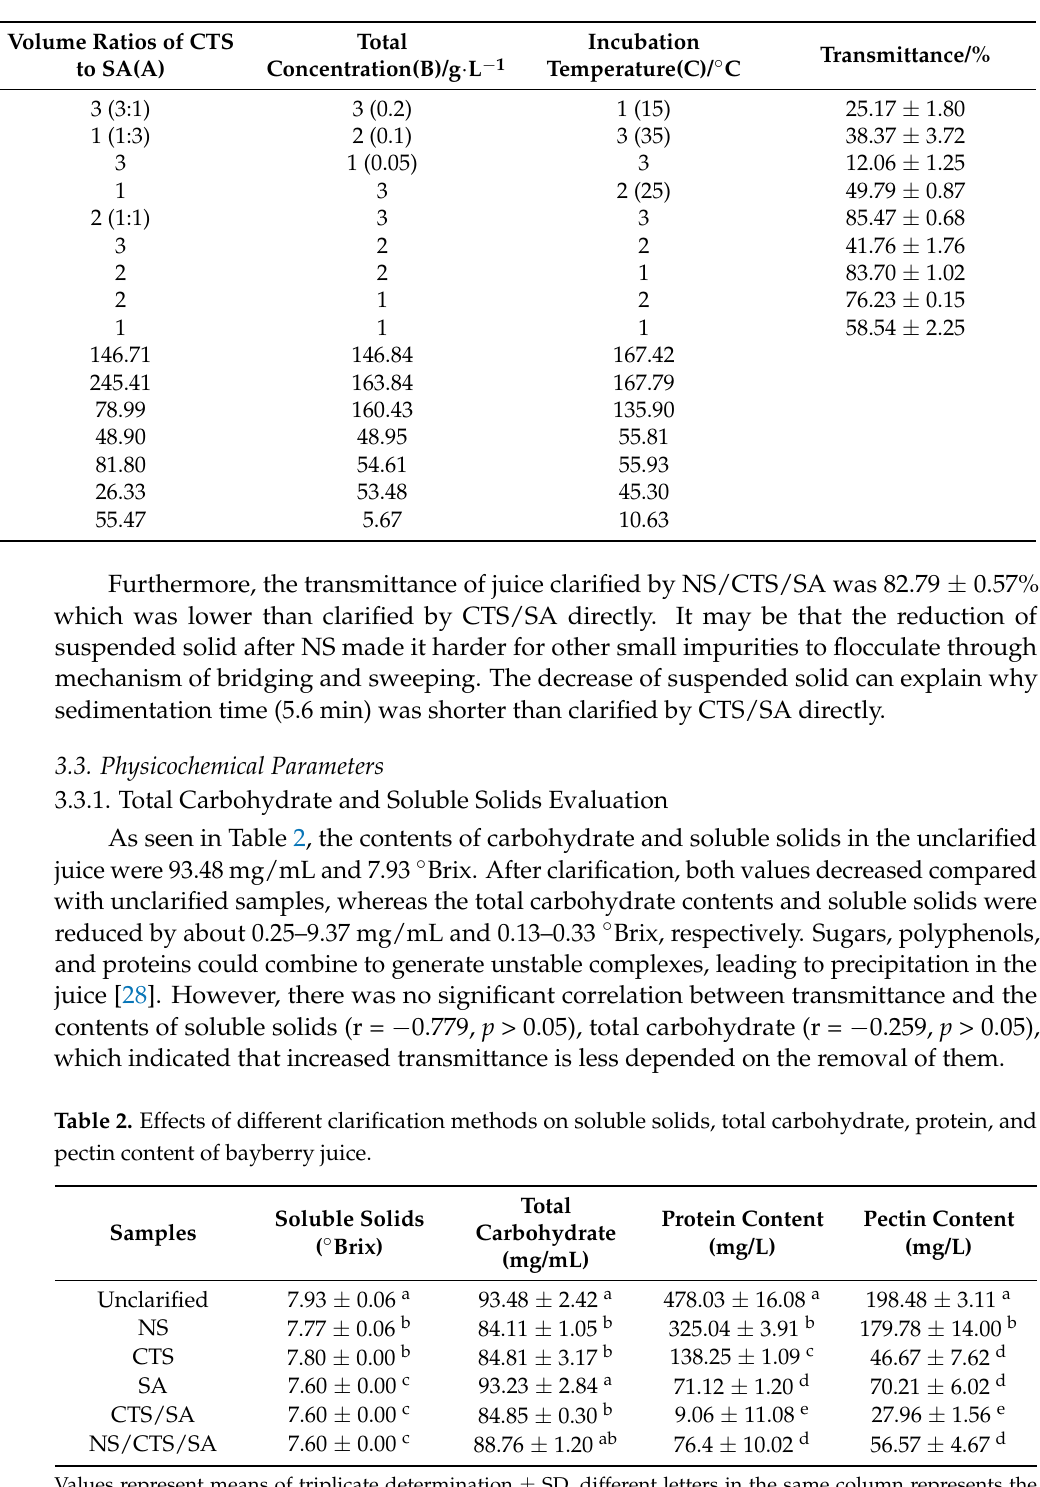
Table 1. Transmittance of bayberry juice treated by composite clarifiers in orthogonal test.